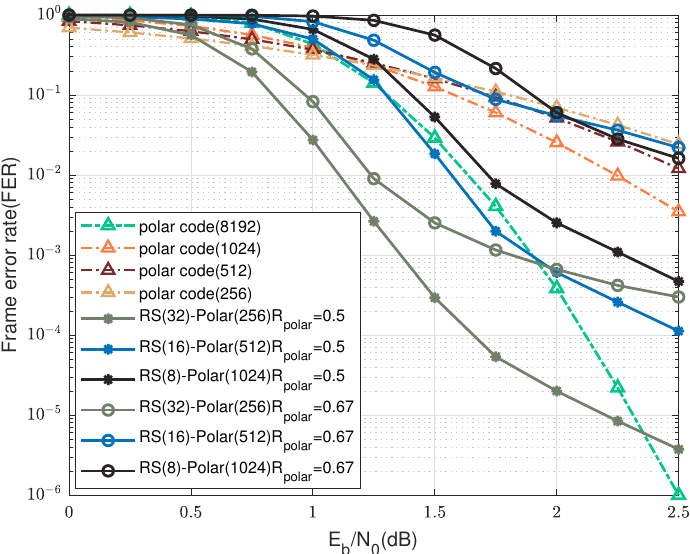
Figure 14. Comparison between the UEP-RS-polar product codes and the SC decoding of single polar codewords over GE channels, for R tx ≈ 1/3, P GG = 0.99 and R polar = 0.5,